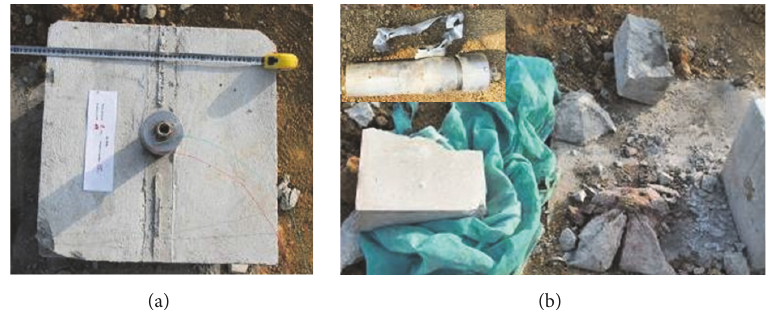
Figure 5: The states of the cement block: (a) before and (b) after being blasted.